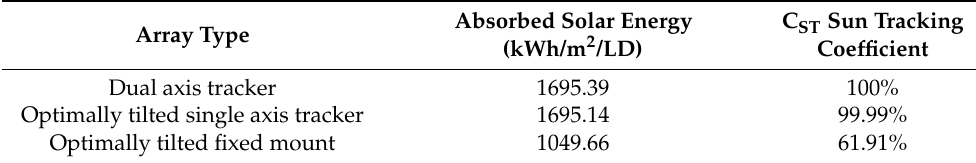
Table 6. Solar energy absorbed per unit surface by various types of solar